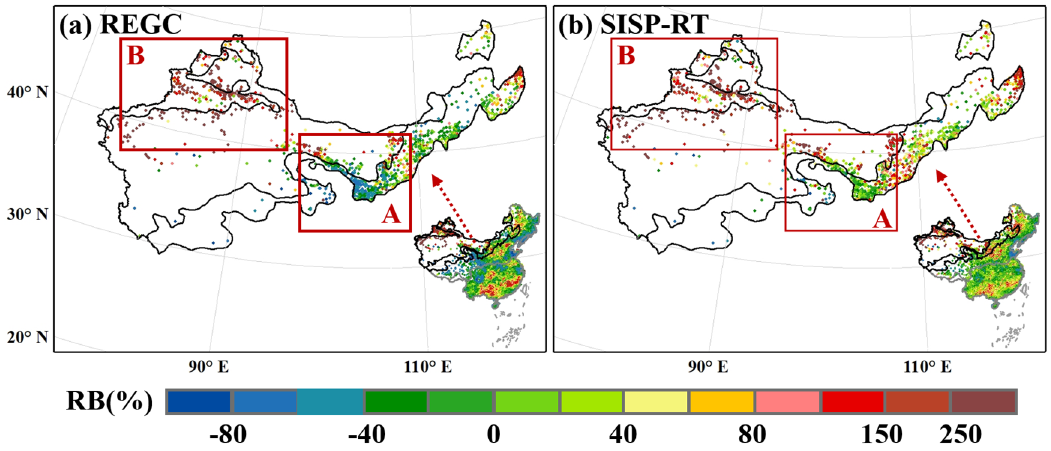
Figure 8. Spatial pa tt erns of RB for the REGC and SISP-RT in the semi-arid and arid regions.